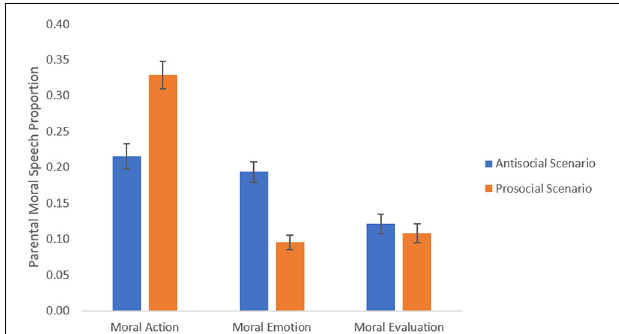
FIGURE 3 | Cross-cultural differences in attention of target character as a function of moral scenario. Error bars represent the ± 1 standard error (SE).